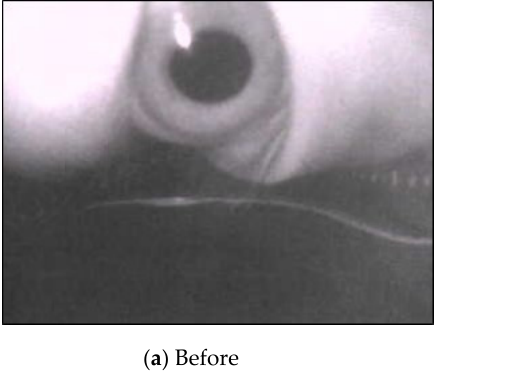
Figure 13. Results of bilateral filtering